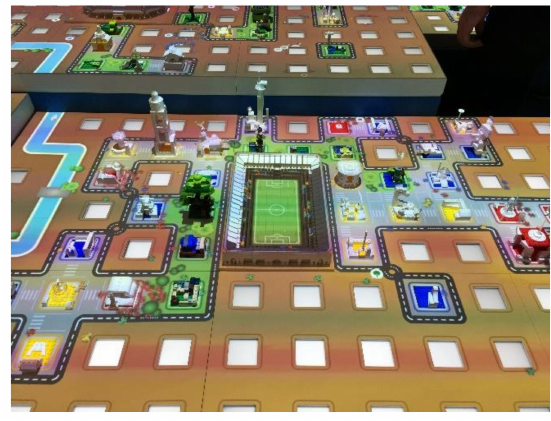
Figure 4. City Architect interactive